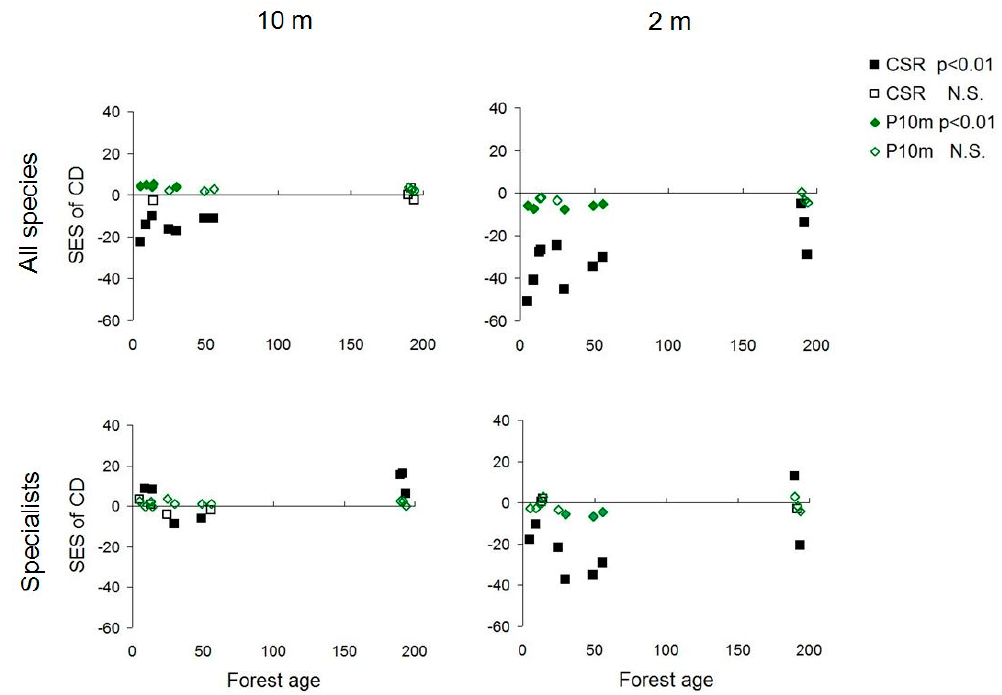
Figure 5. Null model ‐ based beta diversity trends along the chronosequence. Standard effect size of Compositional Diversity (SES of CD). CSR = null model based on Complete Spatial Randomizations, P10m = Patch model randomization with 10 m diameter.